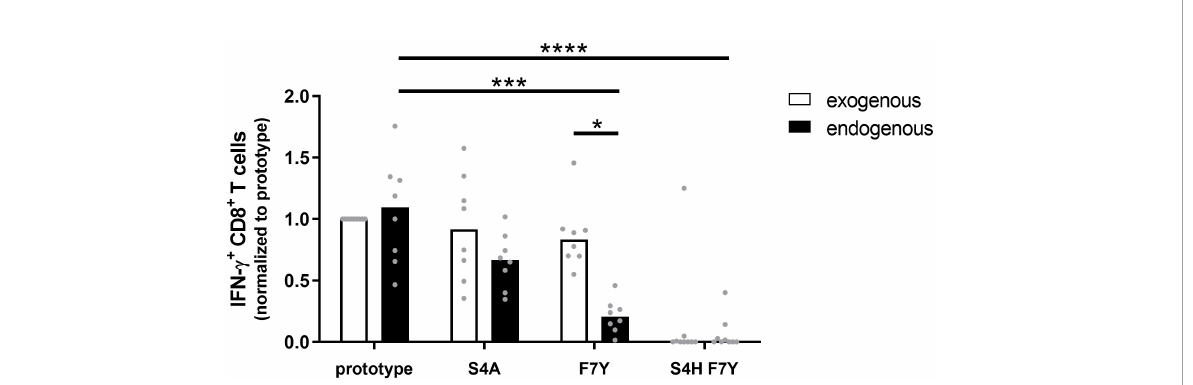
FIGURE 5 CD8 + T cell response against the endogenously processed epitope core 18-27 . Target cells stably expressing the HBV core protein were generated by transduction of HepG2 cells with prototype or variant HBV core (aa1-183) fused to mCherry. Effector T cells from different HLA- A*02:01-positive donors were expanded for 10 days in the presence of the core 18-27 peptide FLPSDFFPSV. HBV core expressing HepG2 cells (endogenous) or peptide-pulsed HepG2 cells (exogenous) were used as targets for re-stimulation of core 18-27 -speci fi c effector CD8 + T cells in an effector:target ratio of 1:1 followed by an ICS. The IFN g response was normalized to the response against HepG2 cells with prototype peptide. P-values were calculated by One-way Anova with a Bonferroni ’ s Multiple Comparison Test. *p < 0.05; ***p < 0.001; ****p <